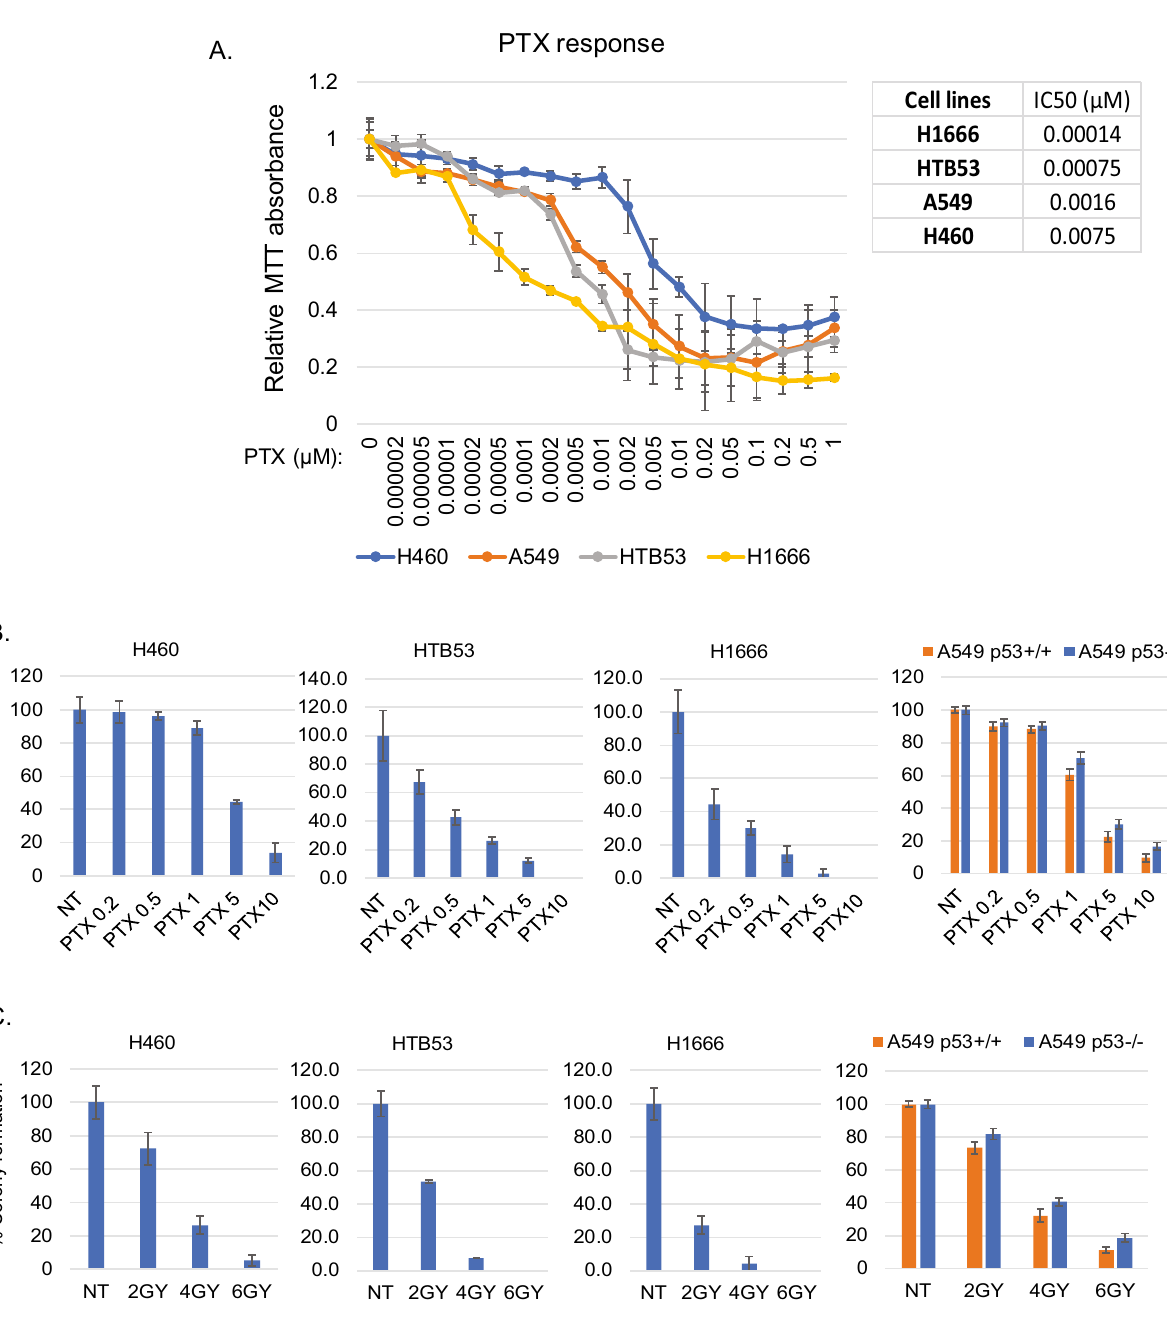
Figure 4. Cells with high RBL2/low AURKA/B pathway genes are sensitive to PTX and irradiation therapies. ( A ) The indicated cell lines were plated in 96-well plates and treated with the indicated doses of PTX for 72 h and then analyzed with MTT. Relative average (8 technical replicate from one experiment) MTT absorbance is presented with SD indicated. ( B ) The indicated cell lines were treated with increasing doses of PTX (μM) for 48 h and then allowed to recover in drug-free media for 2–4 weeks. % average (3 technical replicate from one experiment) formed colonies are presented with SD indicated. There are significant differences (p < 0.05) between H460 and A549 p53+/+ cells treated with 1 μM, 5 μM, and 10 μM of PTX. There are significant differences (p < 0.01) between H460/A549 and HTB53/H1666 cells treated with all doses of PTX. There are significant differences (p < 0.05) between HTB53 and H1666 cells treated with all doses of PTX. There are significant differences (p < 0.05) between A549 p53+/+ and A549 p53−/− cells treated with 1 μM, 5 μM, and 10 μM of PTX. ( C ) The indicated cell lines were treated with 2 Gy, 4 Gy, or 6 Gy irradiation and then allowed to recover for 2–4 weeks. % average (3 technical replicate from one experiment) formed colonies are presented with SD indicated. There is no significant difference (p > 0.05) between H460 and A549 treated with all the doses of irradiation. There are significant differences (p < 0.01) between H460/A549 and HTB53/H1666 cells treated with all doses of irradiation. There are significant differences (p < 0.05) between HTB53 and H1666 cells treated with all doses of irradiation. There are significant differences (p < 0.05) between A549 p53+/+ and A549 p53−/− cells treated with all doses of